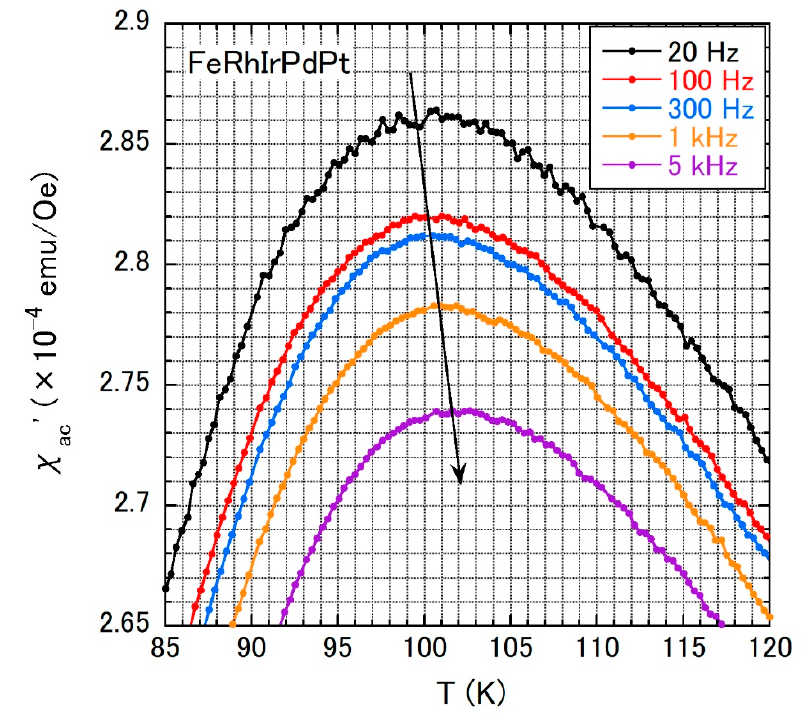
Figure 6. Temperature dependences of χ ac’ under ac frequencies of 20 Hz, 100 Hz, 300 Hz, 1 kHz, and 5 kHz for FeRhIrPdPt. The arrow is a guide to the eyes.